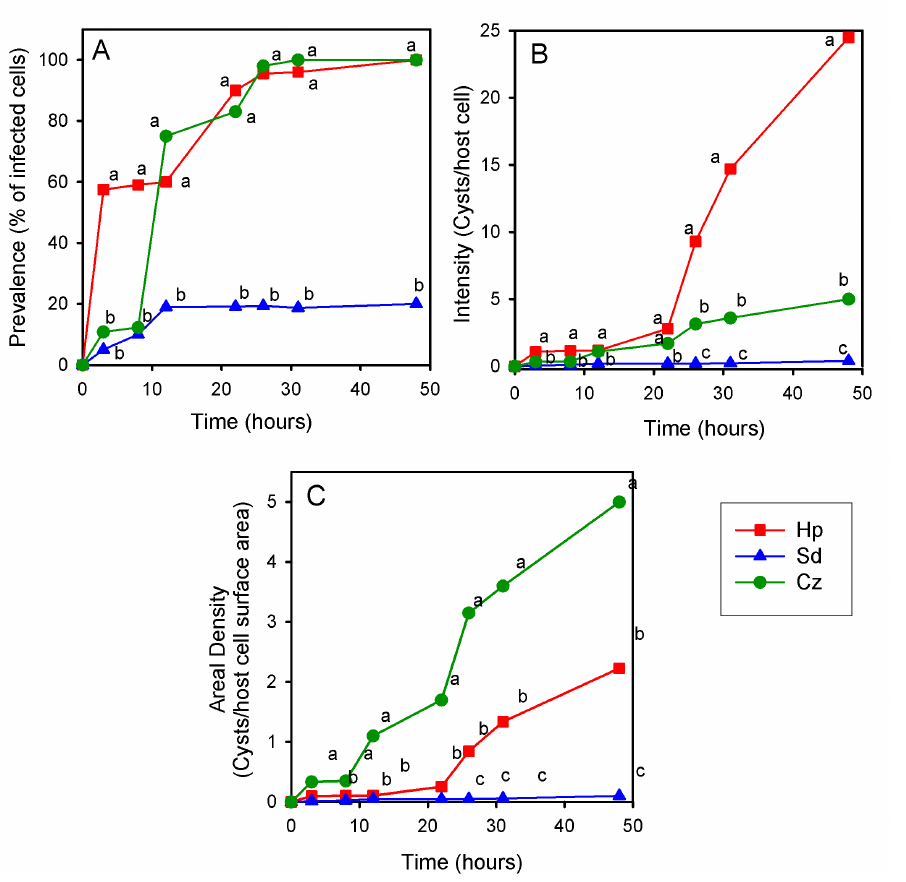
Figure 4. Infection parameters in co-cultures of H. pluvialis (Hp), C. zofingiensis (Cz) and S. dimorphus (Sd) with P. sedebokerense pure propagules inoculated at 1:1 ratio of propagules/host cell, during the first 48 h after inoculation. ( A ) Prevalence, ( B ) Intensity (considering infected and non-infected cells) and ( C ) Areal density per unit area were measured. We normalized the unit areas, considering 1-unit area is the average cell surface of C. zofingiensis (for more details, see Supplementary Table S1). Data presented in this figure are from cultures shown in Figure 3A. Letters indicate statistical significance ( p value <